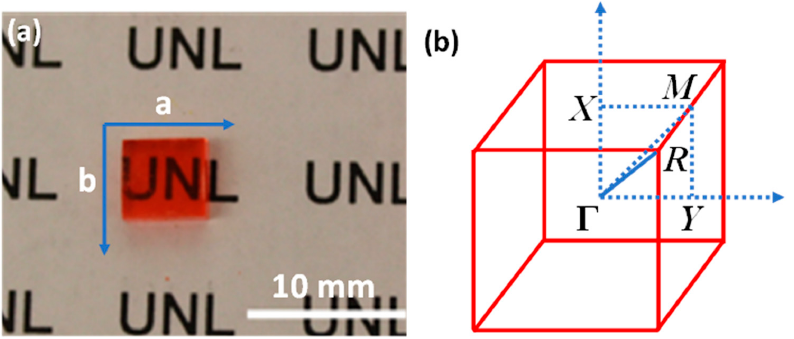
Figure 12. ( a ) MAPbBr 3 single crystal with a surface area of 6 mm × 6 mm. ( b ) The reciprocal lattice of the cubic MAPbBr 3 . From Ref. [104] with permission. Crystals 2020 , 10 , x FOR PEER REVIEW